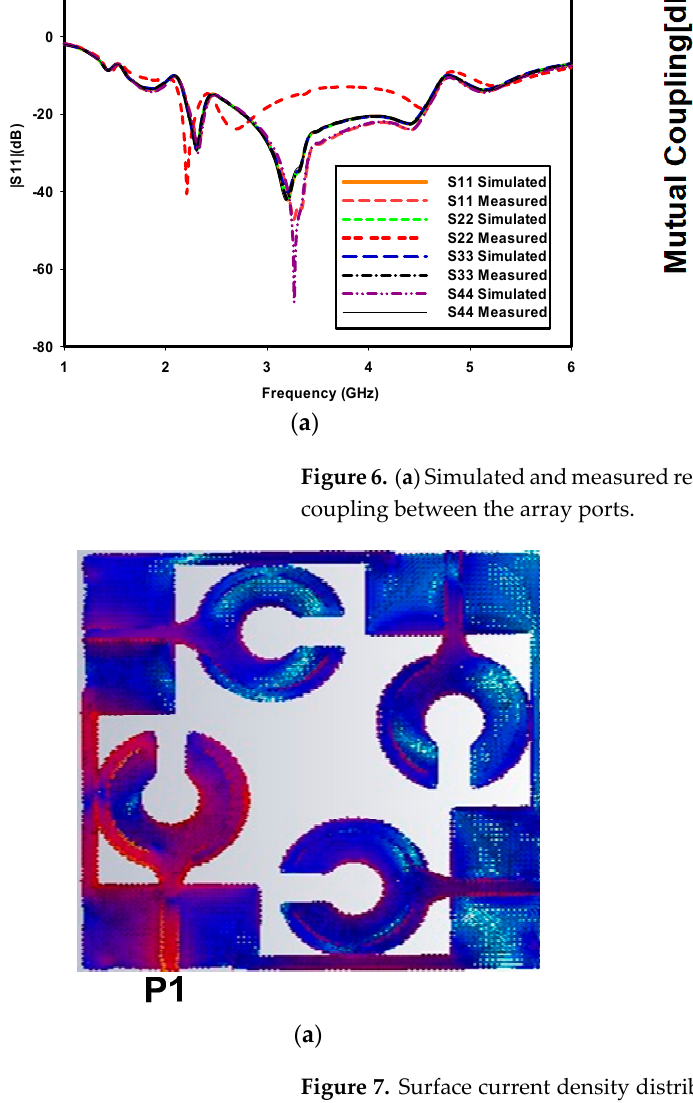
Figure 8. Electric field distribution of the proposed patch antenna at 3.5 GHz. 3.3. Far-Field Radiation Patterns The tests were carried out in an anechoic chamber to eliminate reflections and the reception of spurious external signal which is shown in Figure 9. The array was set up on a turntable, and radiation patterns in the azimuthal (H-plane) and elevation (E-plane) planes were measured. Figure 10a,b depicts the simulated and measured co-polarization and cross-polarization radiation patterns of an antenna in both planes (H and E-plane) at 2.4 and 3.5 GHz respectiely. The co-polarization radiation in the H-plane has an oval shape, while the cross-polarization radiation has a figure eight shape. The cross-polariza- tion radiation resembles a tighter figure eight shape in the E-plane, while the co-polariza- tion radiation has an oval shape with compression on the right side. The array's antennas are arranged orthogonally to one another, which results in identical co- and cross-polari- zation in the broadside direction. The far field distribution for both the resonance frequen- cies in the E-plane are directed towards 0 0 and have low side lodes. The remarkable cor- relation between the simulated and measured results is noticed. The simulation and measured gain and radiation efficiency are given in Figure 11. At 2.4 GHz the measured the gain is 2.65 dBi, and at 3.5 GHz the gain is 2.5 dBi. At 4 GHz, 3 dBi of peak gain was observed. At 2.4 GHz, the radiation efficiency is measured to be 78%, while at 3.5 GHz, it is 67%. The measured peak efficiency at 2.2 GHz is 84%. Inaccurate